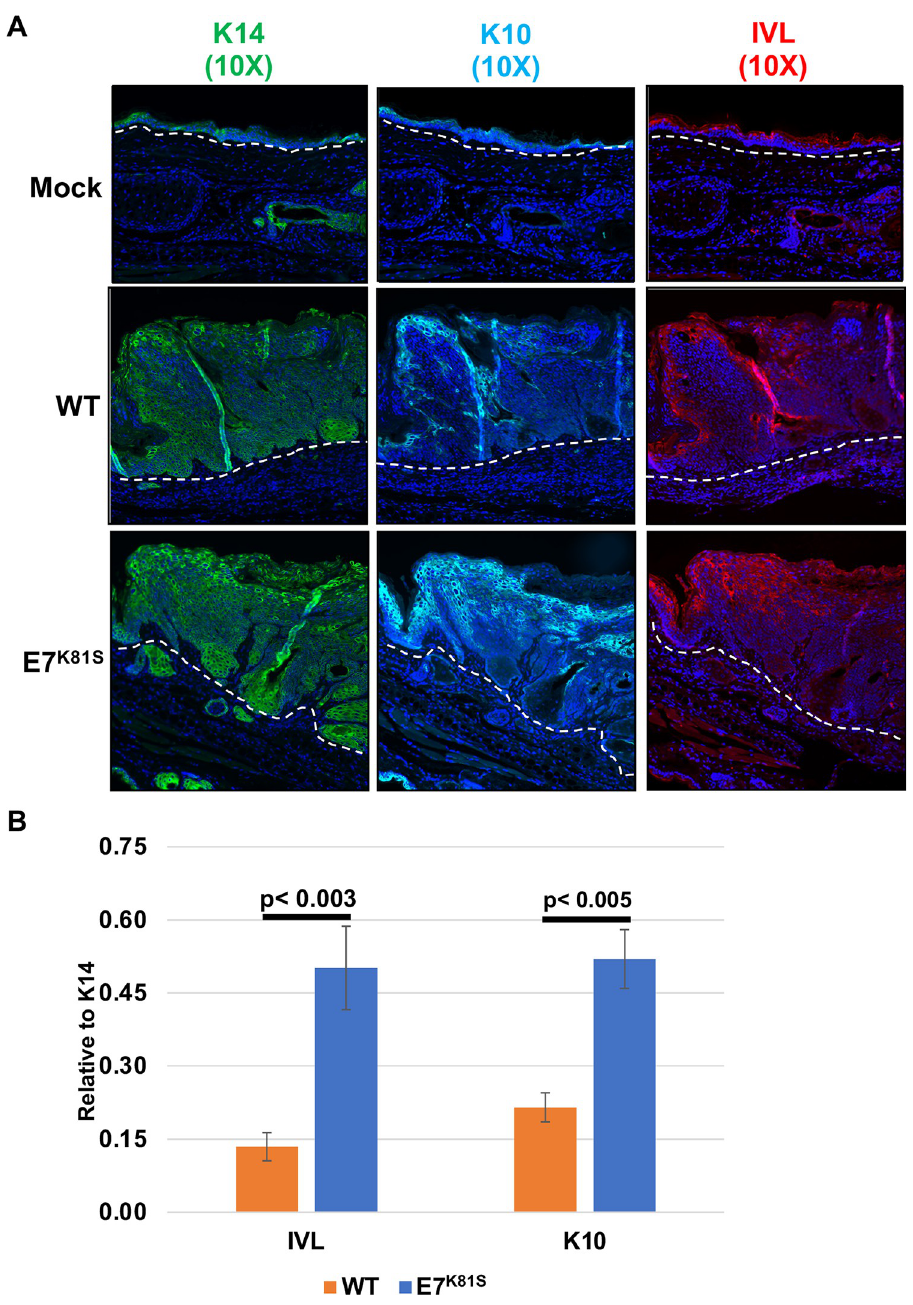
Fig 9. Keratinocyte differentiation is less impaired in the E7 K81S -induced lesions than in WT MmuPV1-induced lesions. (A) FFPE tissue sections were subjected to Immunofluorescence (IF) using antibodies against K14 (green), K10 (cyan), and Involucrin (IVL, red). All sections were stained with the same secondary antibody (anti-mouse conjugated to AF488) and all images are pseudo colored for detection of AF-488. All images are 10X magnification. (B) IF images were quantified using ImageJ determining area with lesion that stained positive for K10 and IVL using 6 images per condition. K10 and IVL signal was normalized to K14 signal. Standard error is shown. Wilcoxon rank sum test was performed to assess statistical significance, and p-values are